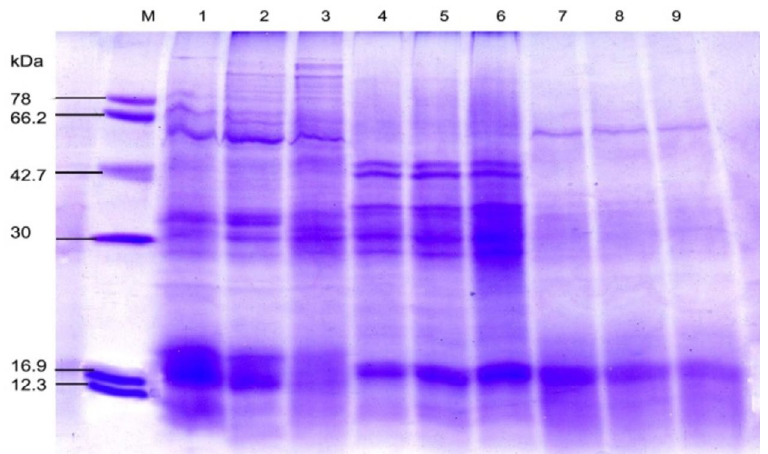
Fig. 4. SDS-PAGE of the protein profiling of three sub-aerial cyanobacteria isolates Scytonema coactile , Lane 2-3; S . geitleri , Lane 5-6and Lyngbya aerugineo-coerulea , Lane 8-9 grown at pH 6 and 9 up to 15 days. An equal amount of proteins were loaded into each well. Control (pH - 7.4), Lane 1,4 and 7; M. Molecular mass of standard proteins in kDa.